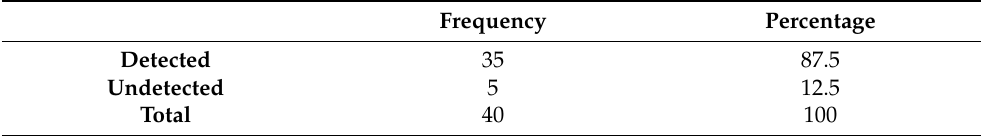
Table 3. Frequency and percentage of successfully detecting door entry/exit event by the door sensor.